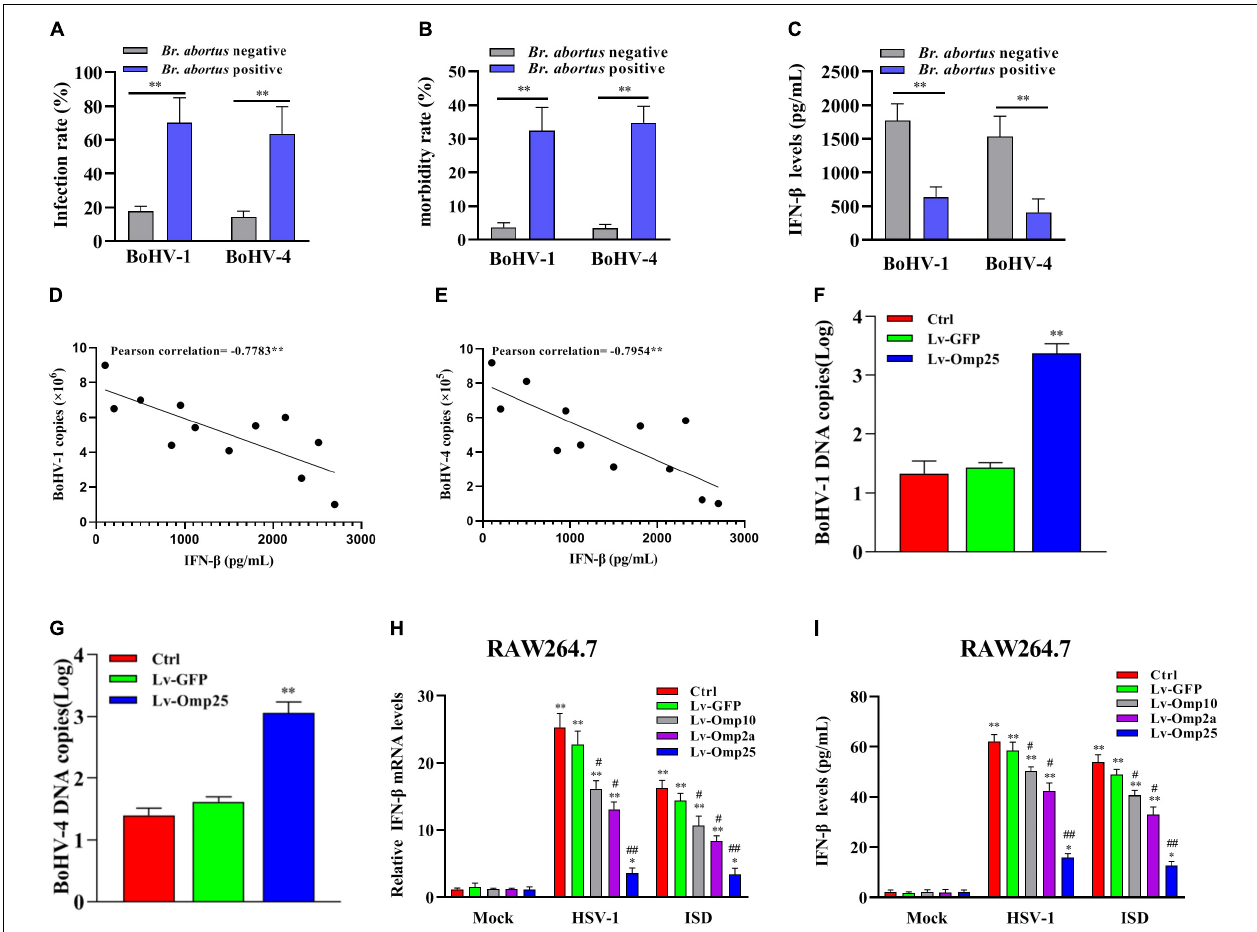
FIGURE 1 | Brucella spp.-positive cattle are more susceptible to BoHV-1 and BoHV-4. (A,B) Serum were collected from Brucella spp.-positive or -negative cattle, and all samples were detected with specific ELISA kits. ** P < 0.01 versus Brucella spp.-negative group. (C) IFN- β levels were lower in Brucella spp.-positive cattle than that in Brucella spp.-negative cattle. Serum was collected from Brucella spp.-positive or -negative cattle coinfection BoHV-1 or BoHV-4; level of IFN- β was detected with ELISA kit. ** P < 0.01 versus Brucella spp.-negative group. (D,E) Level of IFN- β is inversely correlated with either BoHV-1 or BoHV-4 copies in these cattle that infected with or without Brucella spp. ELISA was applied to detect production of IFN- β in different cattle infected with BoHV-1 or BoHV-4 virus; qRT-PCR was applied to detect copies of BoHV-1 or BoHV-4 in these cattle. ** P < 0.01 demonstrated that level of IFN- β is inversely correlated with BoHV-1 or BoHV-4 copies. (F,G) Brucella spp. Omp25 inhibits replication of BoHV-1 and BoHV-4 in MDBK cells. MDBK cells were infected with 100 MOI of Lv-Omp25 or Lv-GFP for 48 h and then infected with BoHV-1 (1 MOI) or BoHV-4 (1 MOI) for another 6 h, qRT-PCR was applied to detect copies of BoHV-1 or BoHV-4. (H,I) Brucella spp. Omp25 is key protein to inhibit expression of IFN- β induced by HSV-1 or ISD in RAW264.7. RAW264.7s were infected with 100 multiplicity of infection (MOI) of Lv-Omp25, Lv-Omp10, Lv-Omp2a, or Lv-GFP for 48 h and then infected with HSV-1 (10 MOI) or transfected with ISD (2 µ g/ml) for another 6 or 24 h. Cells were harvested and subjected to qRT-PCR analysis (H) or ELISA analysis (I) . * P < 0.05, ** P < 0.01 versus mock group, # P < 0.05, ## P < 0.01 versus control or Lv-GFP-infected cells in same secondary or infection stimulation groups. Results are means ± SEMs of three independent